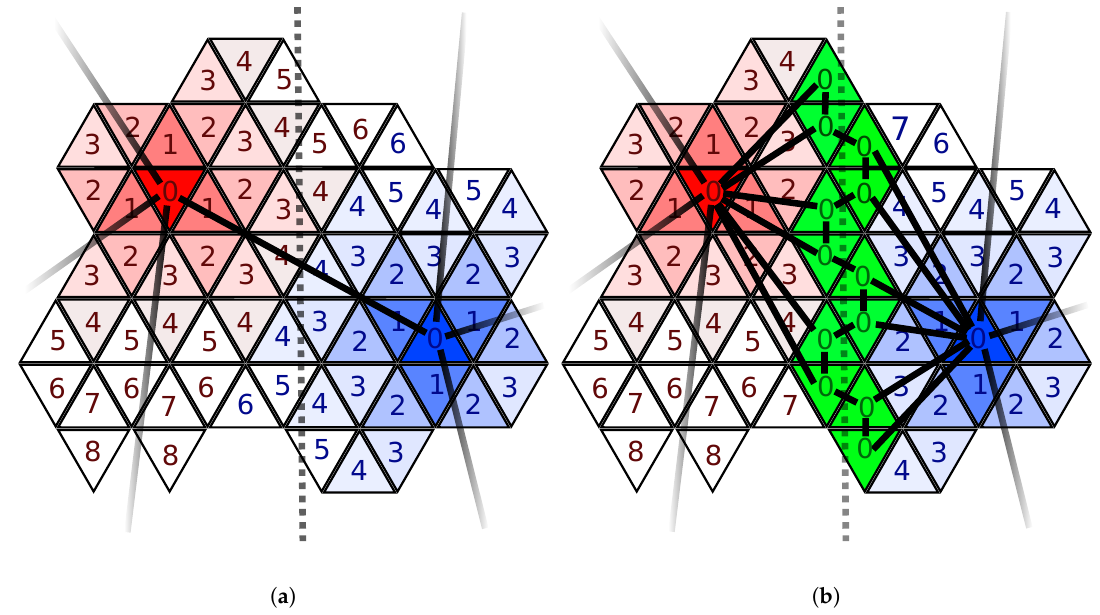
Figure 5. Example region of top layer across a material interface (dotted line). Cells of the sparse set are labeled with 0, while the cells forming the surrounding patch are labeled with their edge distance to the sparse set. Solid black lines denote the connection between the cells of the sparse set. ( a ) the region is partitioned into two patches (red and blue) using d max = 8, omitting material information; ( b ) material interface-aware partitioning using d max = 0 for cells embedding the material interface: the green cells, which are part of the sparse set, follow the material interface and thus allow for a proper